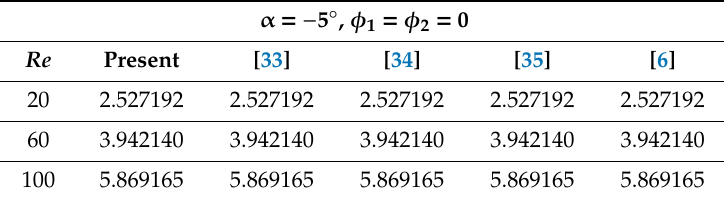
Table 4. Comparison for − F” (0) in opening